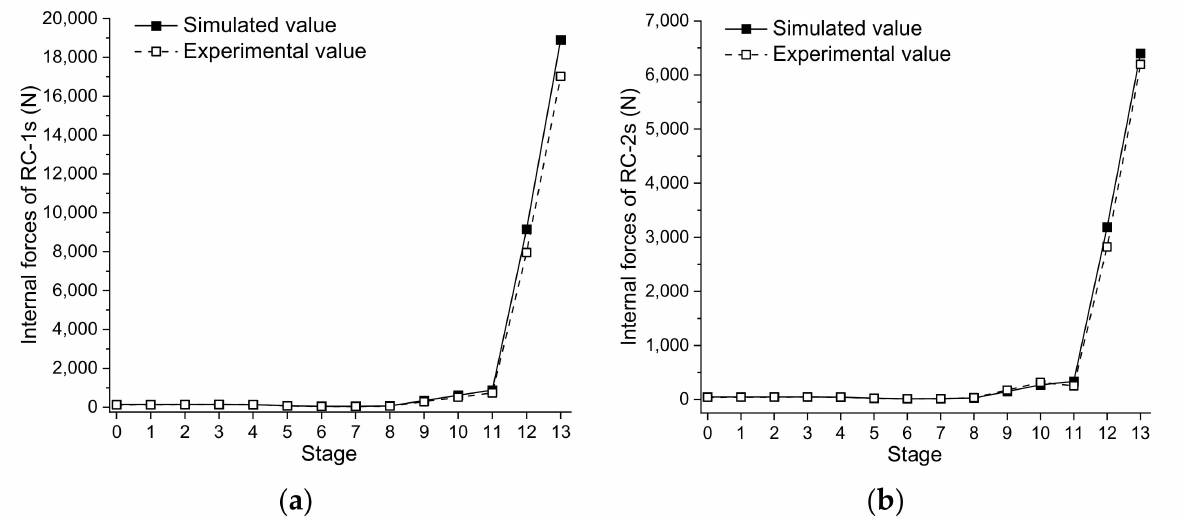
Figure 21. Internal forces of the RCs during construction. ( a ) RC-1; ( b ) RC-2.